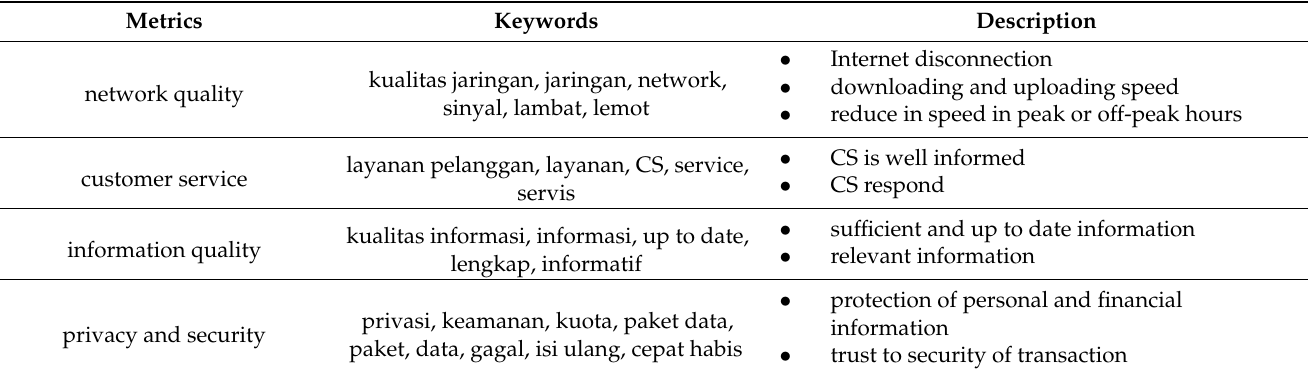
Table 1. Keywords for Thaichon’s service quality metrics of ISPs.